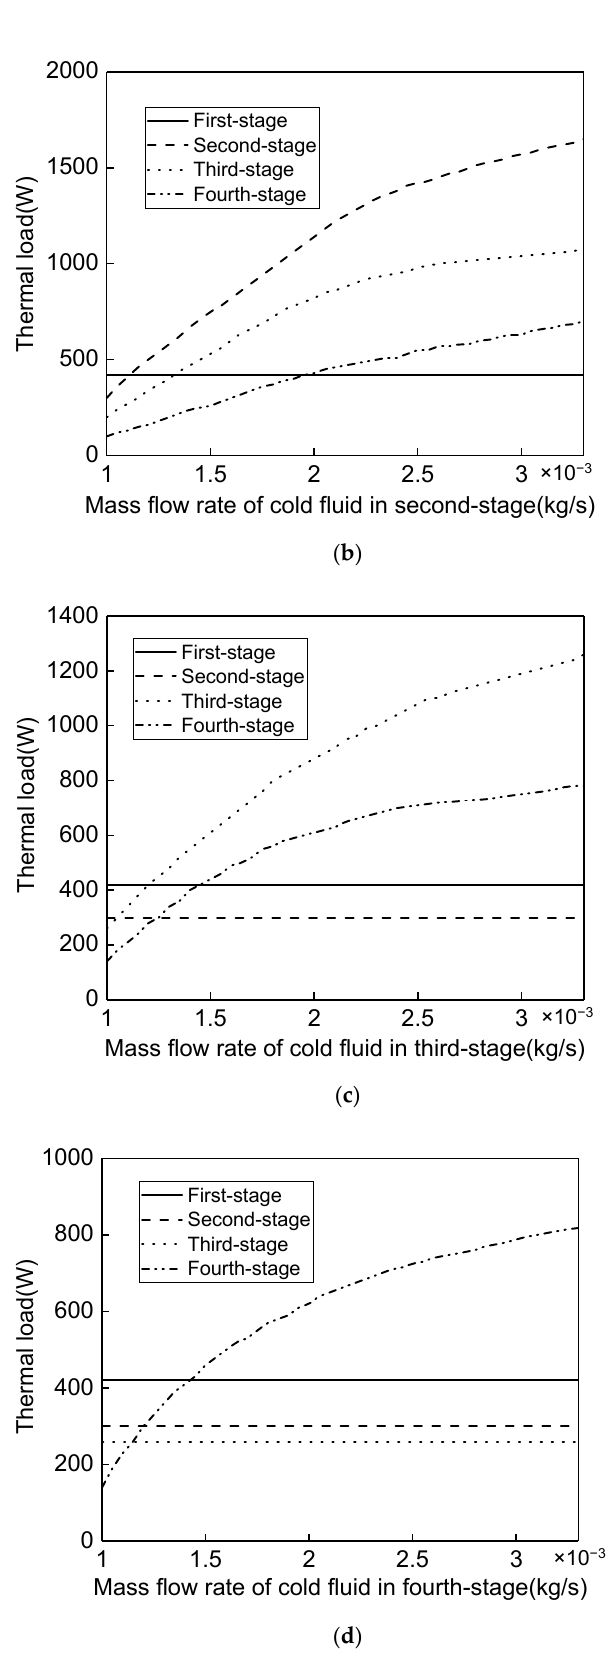
Figure 8. Regulating relationships between thermal load and mass flow rate of cold fluid in each condenser.